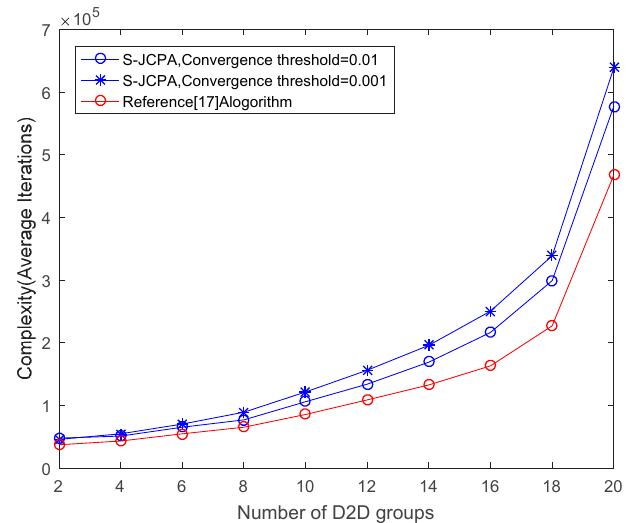
Figure 7. Network complexity for di ff erent algorithms with di ff erent numbers of D2D groups, M = 20.